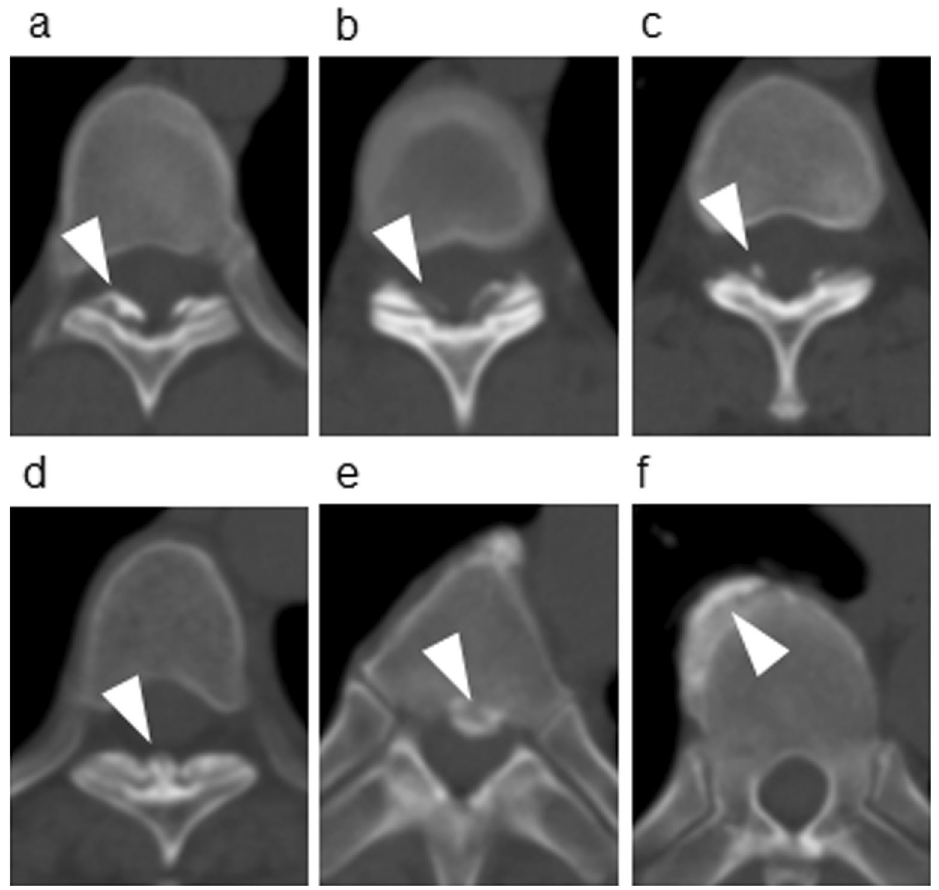
1 mm thickness. ( d) A mushroom-shaped OLF localized at the center of the laminae. ( e) OPLL with thickness ≥ 2 mm. ( f) OALL located in the paramedian region of the anterior vertebral body with a thickness ≥ 4 mm. OLF ossification of the ligamentum flavum, OPLL ossification of the posterior longitudinal ligament, OALL ossification of the anterior longitudinal